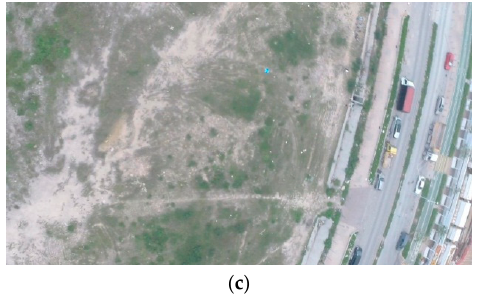
Figure 10. The results of altitude tests with the vehicle cruising at ( a ) 50 m; ( b ) 80 m and ( c ) 100 m.